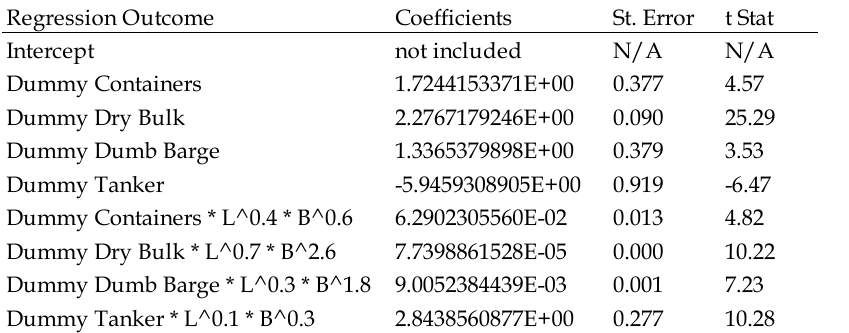
Supporting model for estimating the design draft of inland